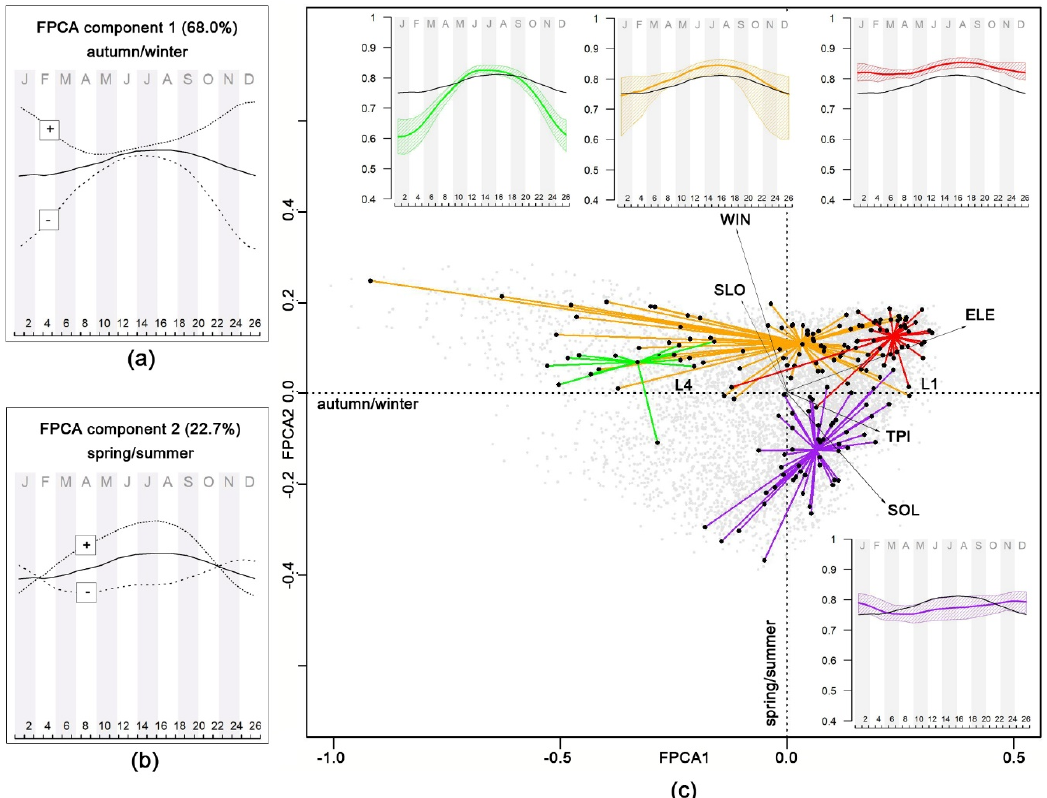
Figure 5. Result of the Functional Principal Component Analysis (FPCA) applied to the mean Landsat 8 pixel-based NDVI time series (2013–2019) of the forests of Mount Conero (Central Italy), and the relationships with lithology, topography, and plant associations. (a) FPCA1 principal functional component (68.0% of the total variation). (b) FPCA2 principal functional component (22.7% of the total variation). (c) Reduced phenological ordination space defined by FPCA1 and FPCA2. Gray dots are all pixel-based NDVI time series. Black dots are the plant associations reference data. Arrows (length proportional to the correlation value) are correlated topographic variables (ELE = elevation, SOL = mean annual solar potential radiation, TPI = topographic position index, WIN = cold wind exposure, SLO = slope) while labels correlated lithologies (L1 = “scaglia rossa” formation, L4 = Landslide deposits). Spiderplots, in di ff erent colors, are the plant associations reference data. With same colors the plant association NDVI mean annual profiles (bold colored line is the median NDVI value, the polygon is the 10–90% percentile; the black line is the mean NDVI values of the study area). Green = Asparago acutifolii–Ostryetum carpinifoliae , Orange = Cephalanthero longifoliae-Quercetum ilicis , Red = Cyclamino hederifolii-Quercetum ilicis , Purple = Pinus halepensis and P. pinea forest